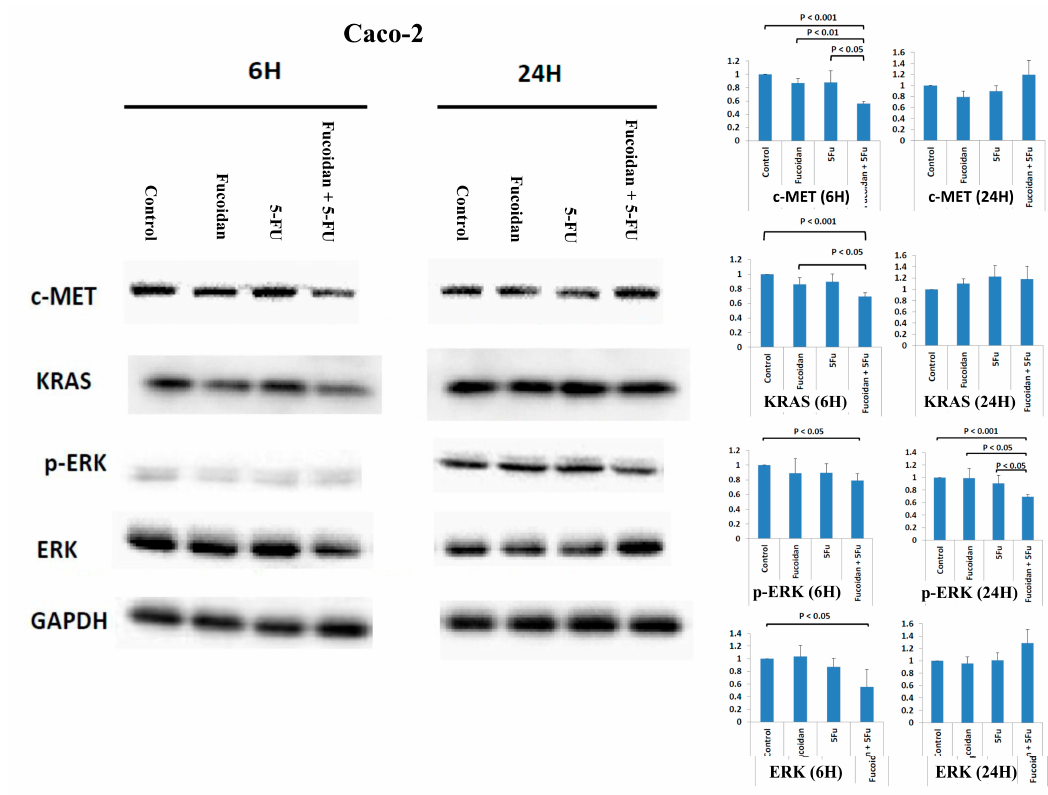
Figure 4. Expressions of c-MET protein, KRAS protein, p-ERK protein, and ERK protein in Caco-2 cells after treatment with LMWF, 5-FU, and combination of LMEF and 5-FU. Data are presented as the means of three independent